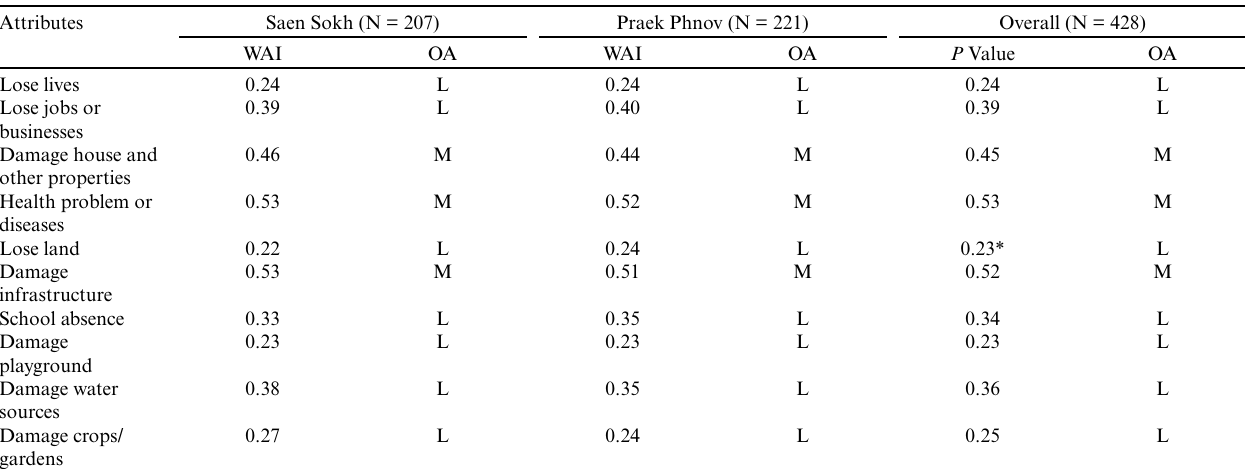
Table 3 . Perceptions on the level of impacts of climate-related risks on urban livelihoods.